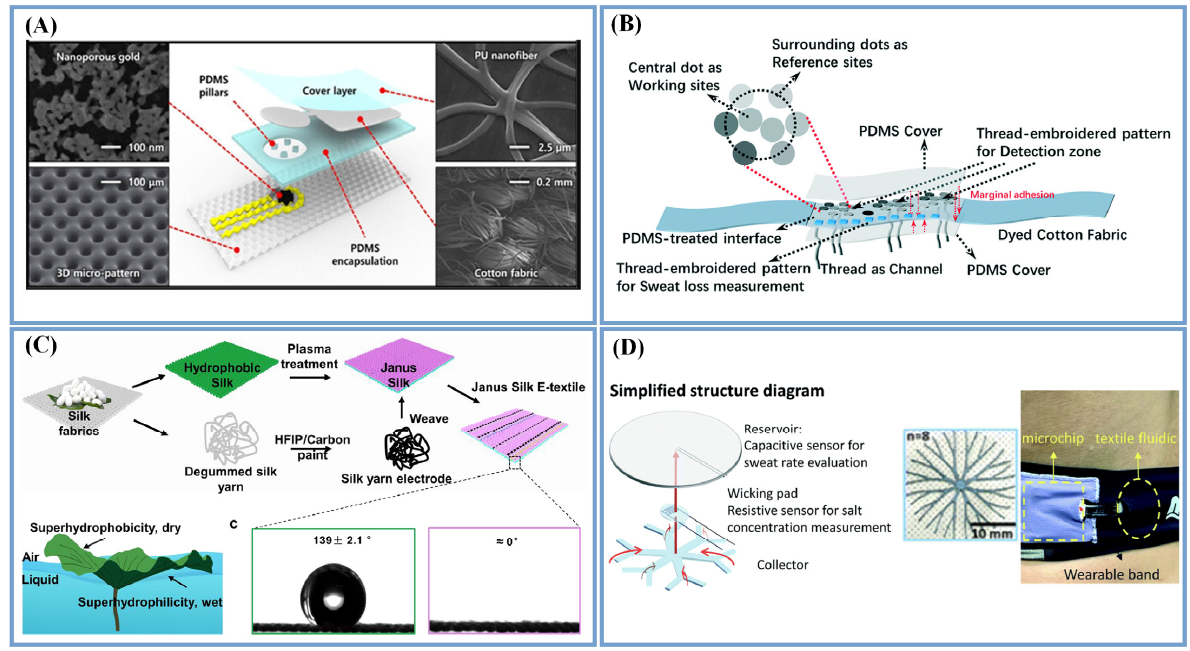
Figure 2. Sweat transportation and collection methods. Cotton fabric ( A ) (Reprinted with permission from Ref. [61]. Copyright 2019, copyright American Chemical Society) and threads ( B ) (Reprinted with permission from Ref. [62]. Copyright 2021, copyright Royal Society of Chemistry) directly used as capillary materials; ( C ) Janus textiles with the asymmetric structure of a lotus leaf (Reprinted with permission from Ref. [64]. Copyright 2021, copyright American Chemical Society); ( D ) Sweat collection device with three-layer structure based on plant roots (Adapted with permission from Ref. [11]. Copyright 2021, copyright Royal Society of Chemistry).